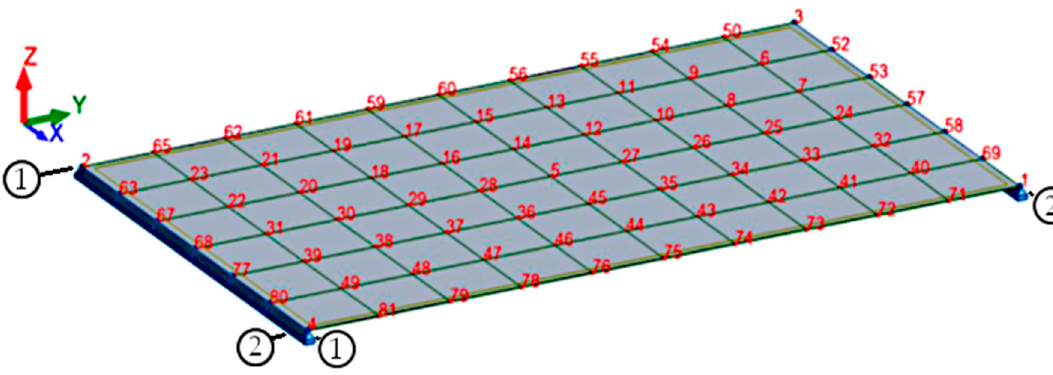
Figure 7. The numerical model of the slab element.